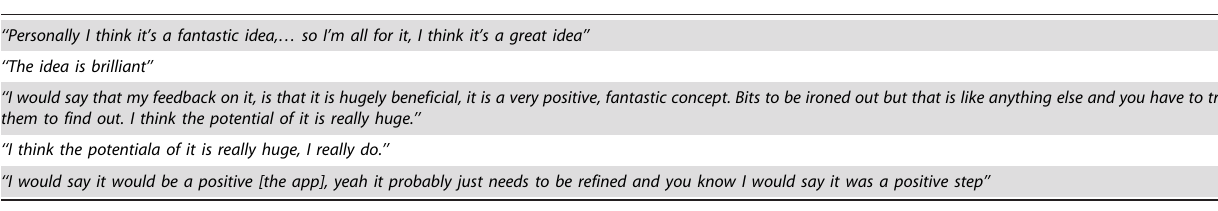
Table 3. Public Health Nurse (PHN) reaction to the